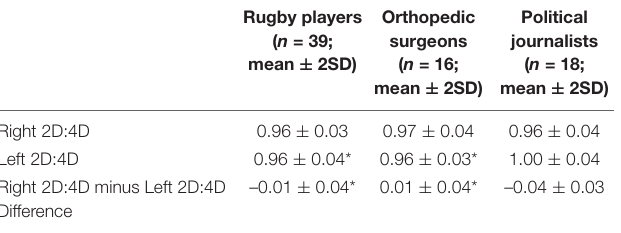
TABLE 3 | Study 3 digit ratio comparisons between groups.